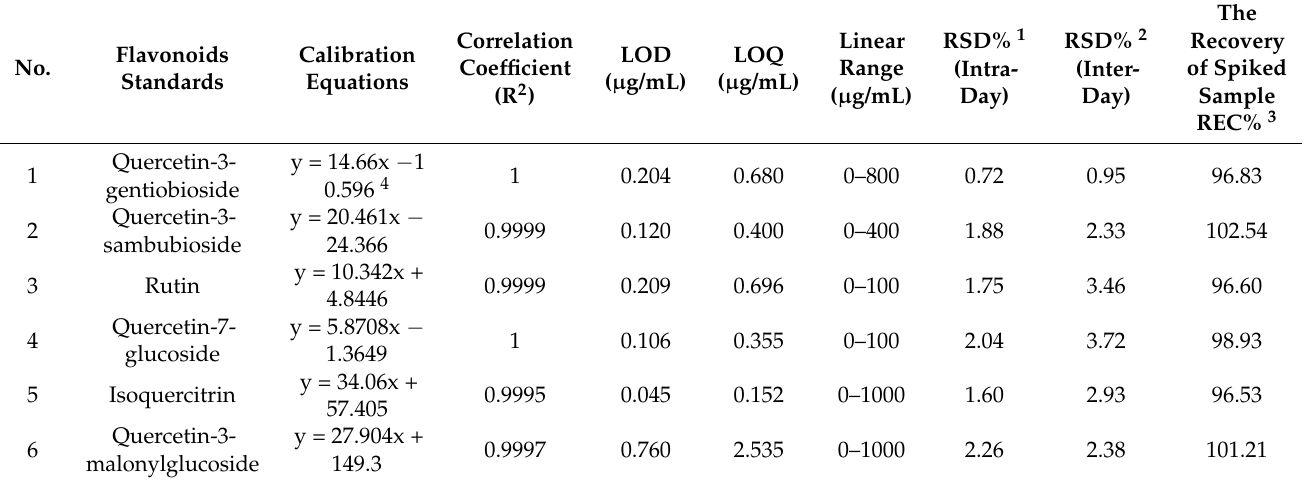
Table 2. Linearity, Precision and Accuracy Results for Tested